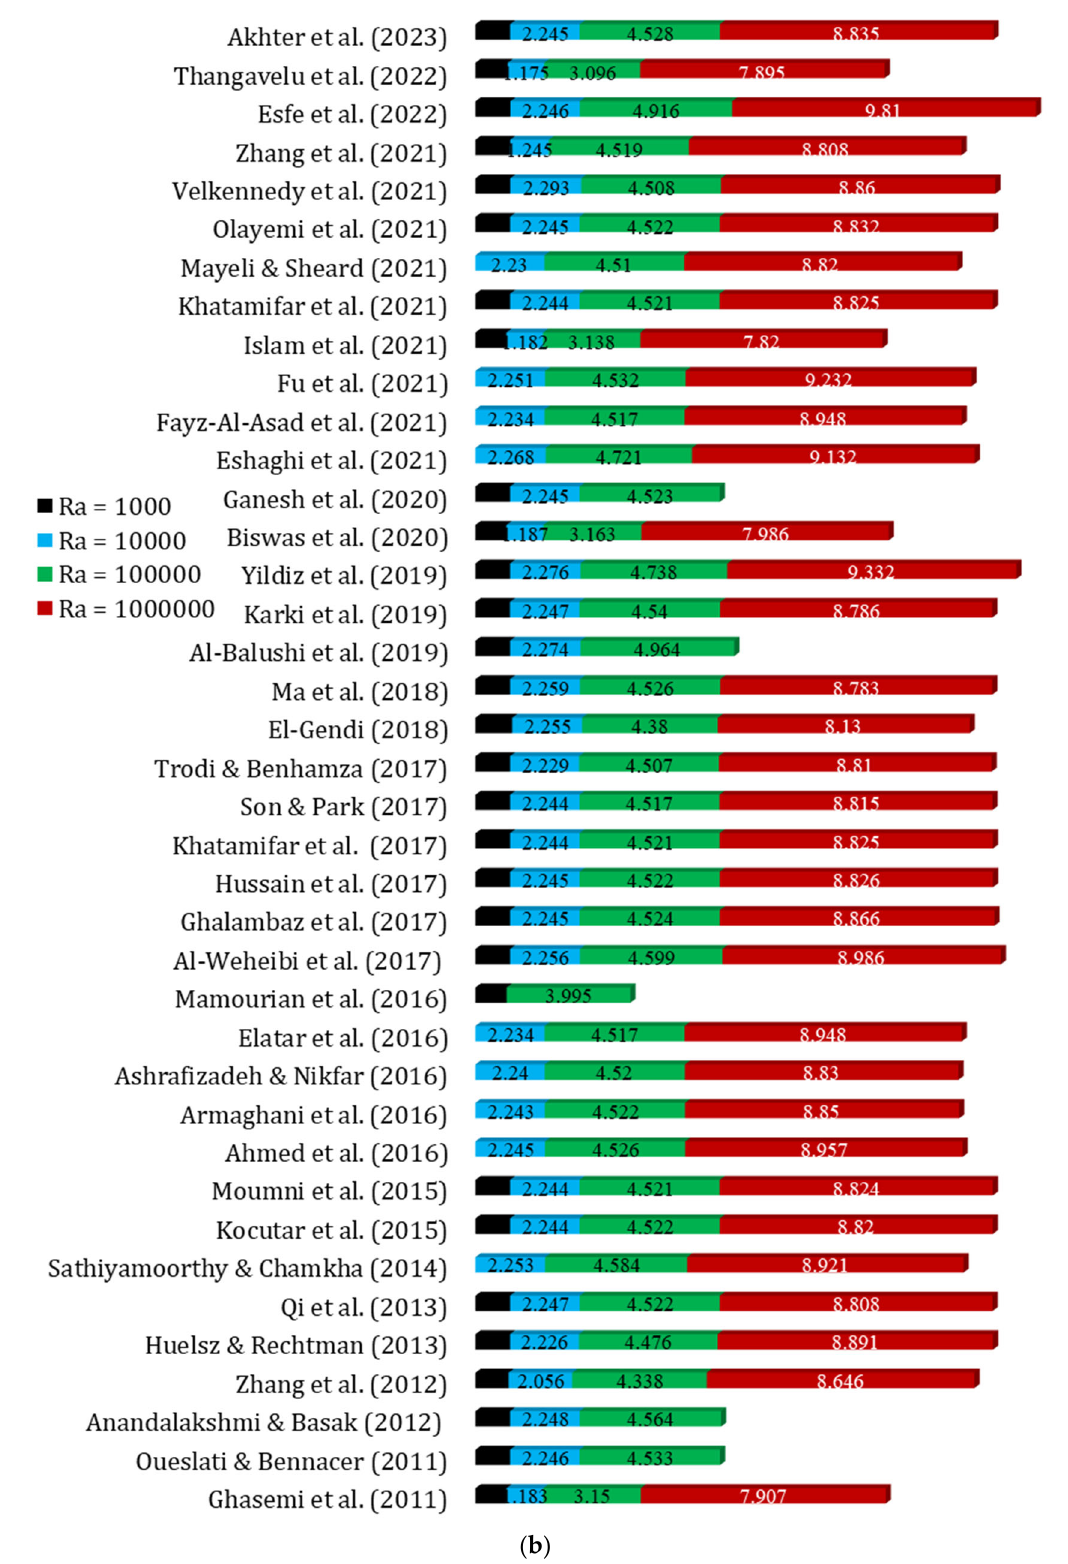
Figure 5. ( a , b ): Variation of Nu avg with different Ra for Pr = 0.71 (Case: Natural convection flow in a square cavity) [2,7,9,18,52,71,75,79,89,94,99,103,149,162,163,179,212–267].